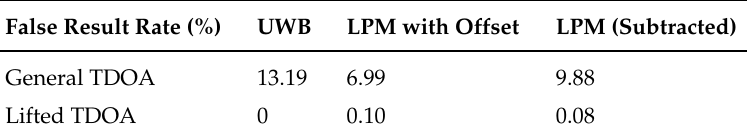
Table 3. The self-localization results are based on a 2D model with synthetic data and known reference stations positions. The identified false optimizations have an error larger than 0.1.